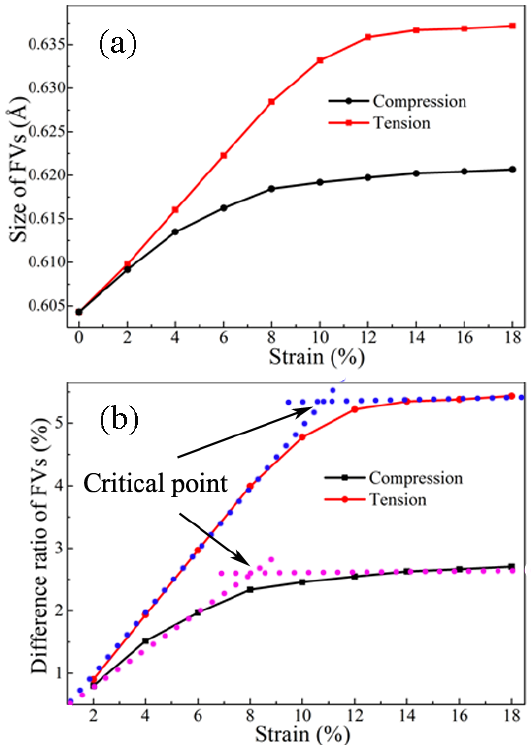
Figure 4. (Color online) Relations between FVs (free volumes; large voids whose radii are larger than 0.4 Å) and strain in tension and compression modes, including ( a ) the average sizes of FVs and ( b ) the difference ratio of FV sizes in different strains. The dotted lines are two straight lines indicating the approximate relations between FVs and